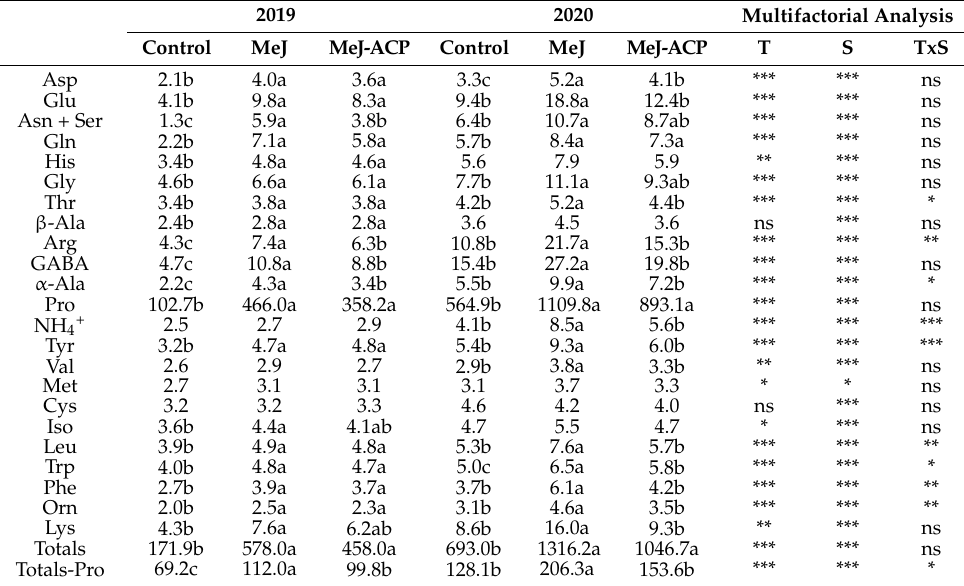
Table 4. Nitrogen composition in Monastrell wines from non-treated and treated grapes with MeJ and MeJ-ACP at the end of alcoholic fermentation (expressed as mg